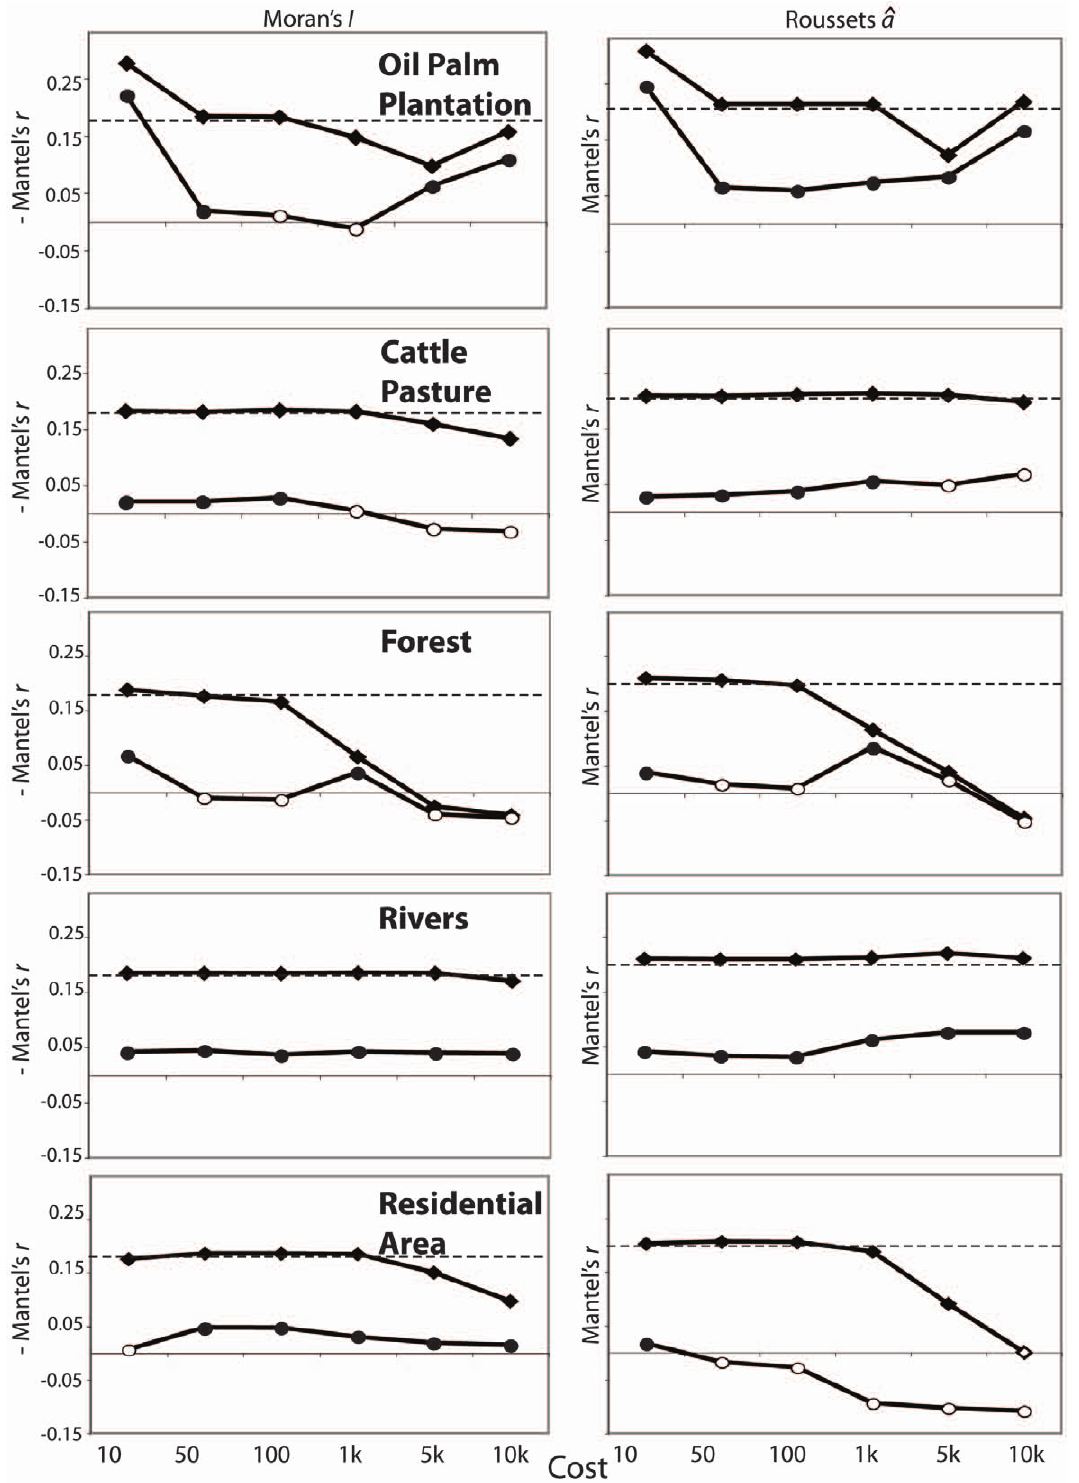
Figure 3. Results of Mantel tests of least-cost distances against genetic relationships, including all pairs of individuals. Negative Mantel’s r- values are given (left) for Morans’ I for easier comparison with trends in Rousset’s aˆ (right). Filled symbols (diamonds for simple Mantel tests and circles for partial Mantel tests) represent statistically significant Mantel’s r- values in the expected direction (positive for aˆ and negative for I ). Dotted lines represent the Mantel’s r- value for Euclidean distance against genetic distance.